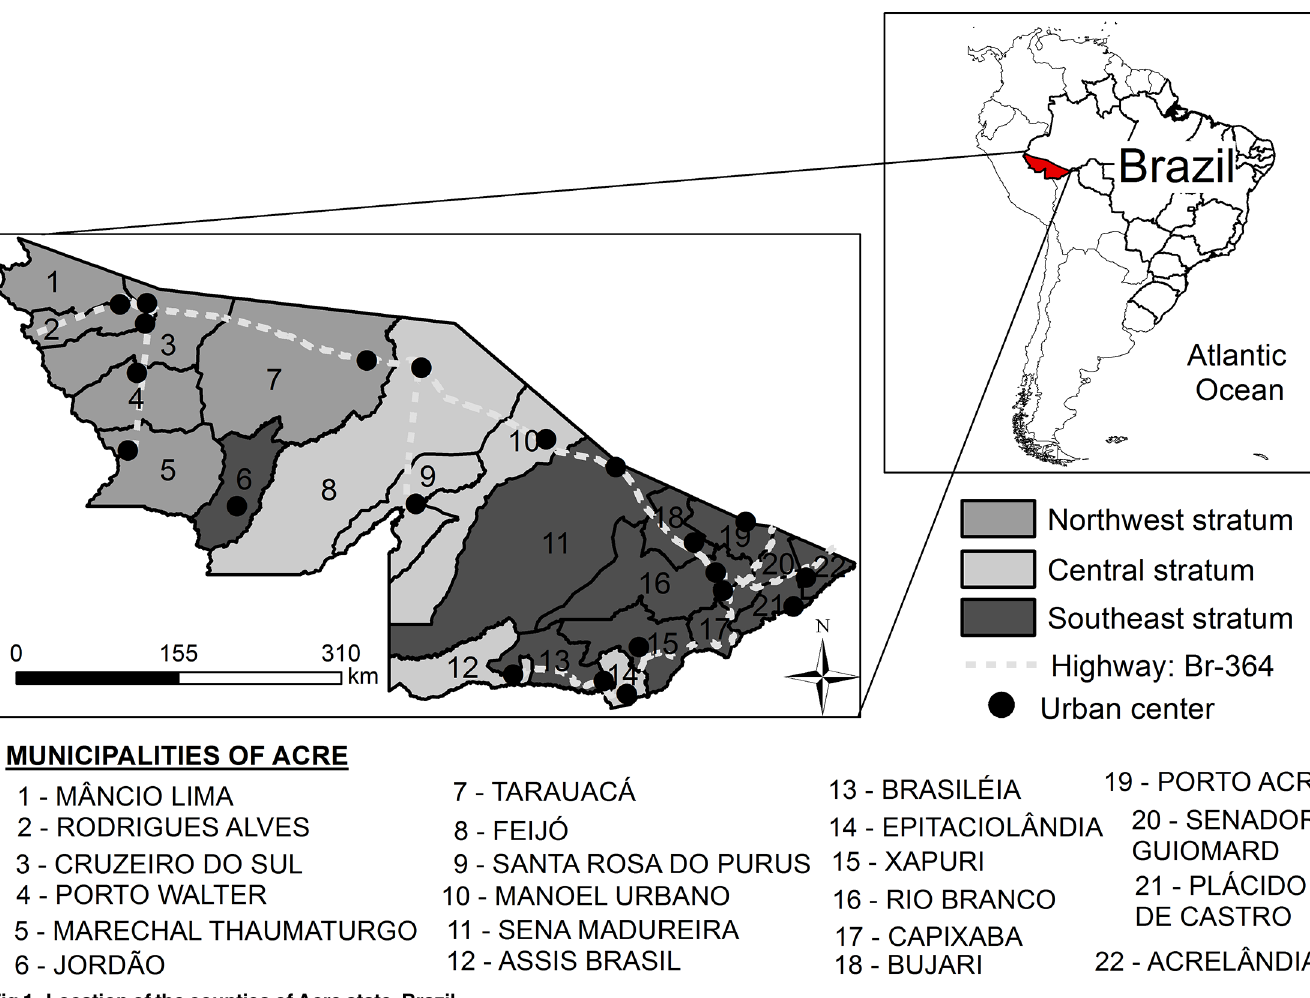
Fig 1. Location of the counties of Acre state,